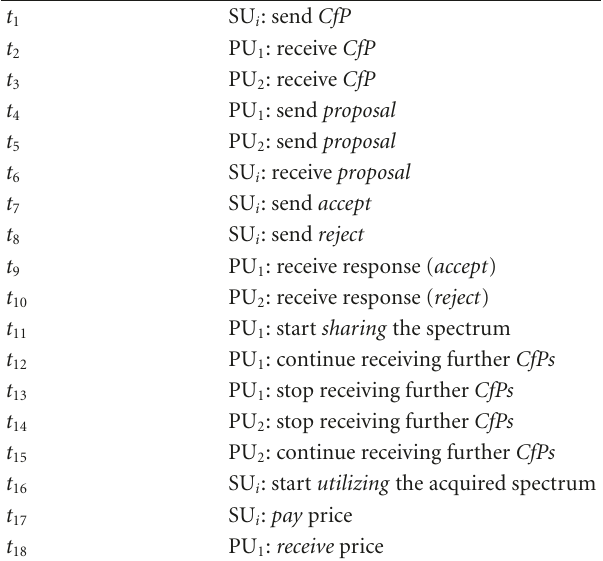
Table 2: Various transitional